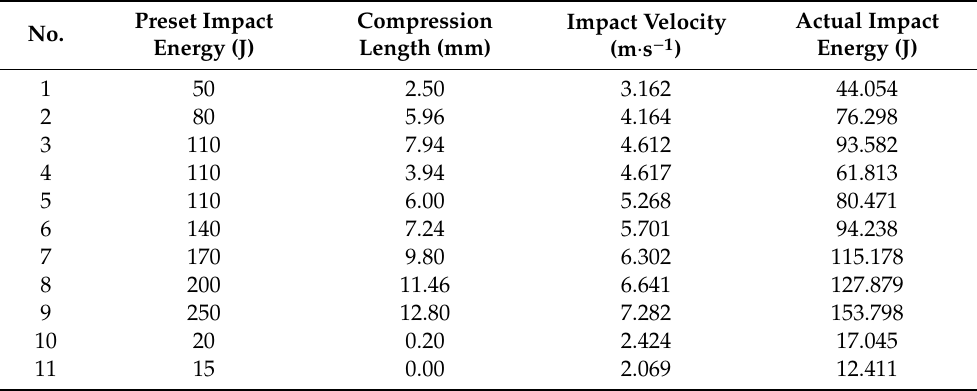
Table 1. Results of the drop-weight impact